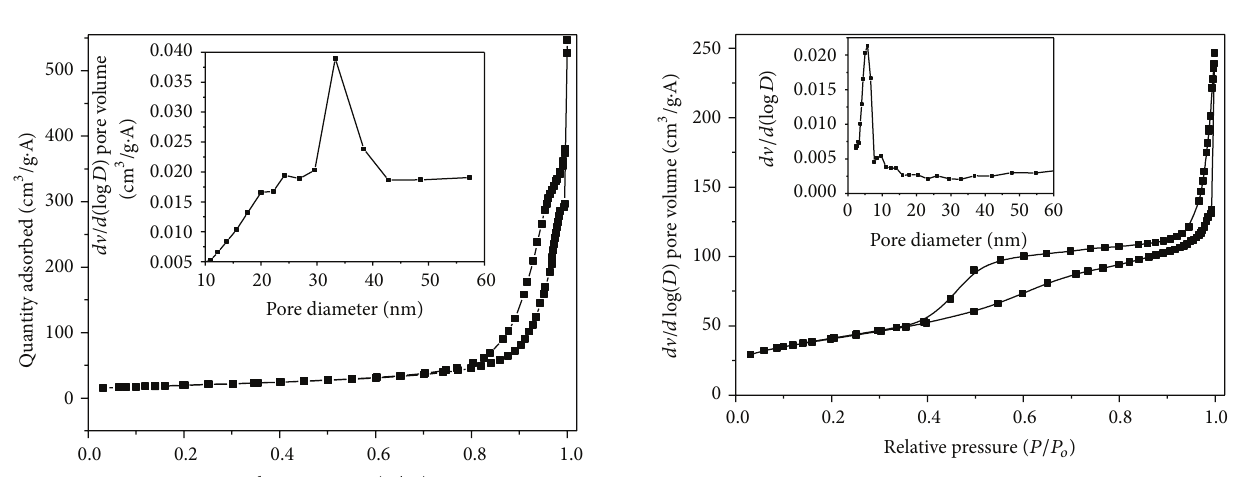
Figure 6: Nitrogen adsorption-desorption isotherm of the CCA/ TiO 2